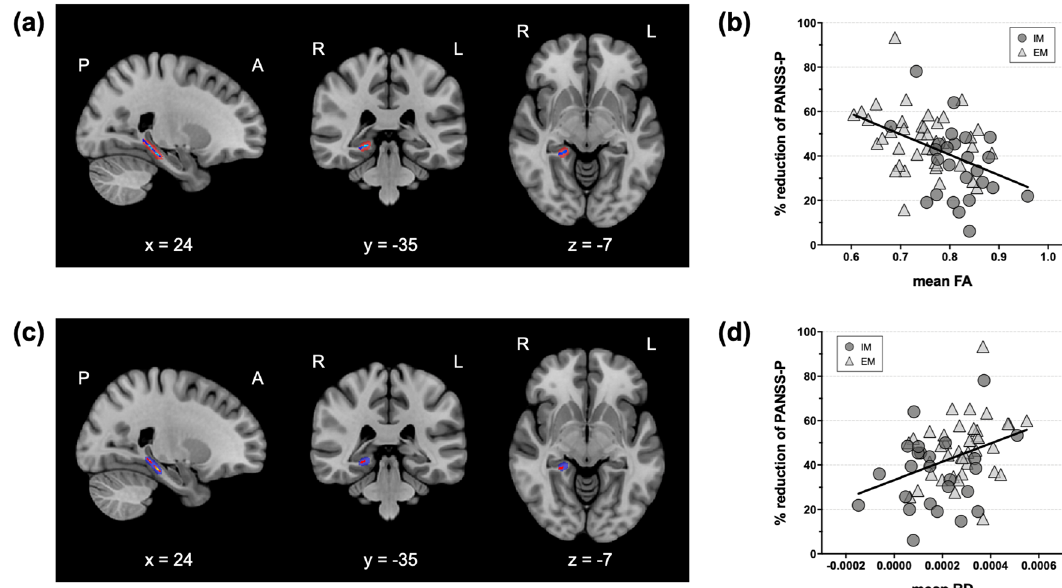
Fig. 3 Associations between CYP2D6-associated hippocampal white matter connectivity and treatment response after 4 weeks of APD treatment. Higher FAs ( a , b ) and lower RDs ( c , d ) were associated with lesser improvements in positive symptoms (TFCE-corrected p < 0.05). The red ( a ) and blue areas ( b ) indicate the regions showing signi fi cant differences in FAs and RDs between the IM and EM groups, respectively. CYP2D6 cytochrome P450 2D6, APD antipsychotic drug, FA fractional anisotropy, RD radial diffusivity, PANSS-P the positive symptom subscale of the Positive and Negative Syndrome Scale, TFCE threshold-free cluster enhancement, IM intermediate metabolizer, EM extensive